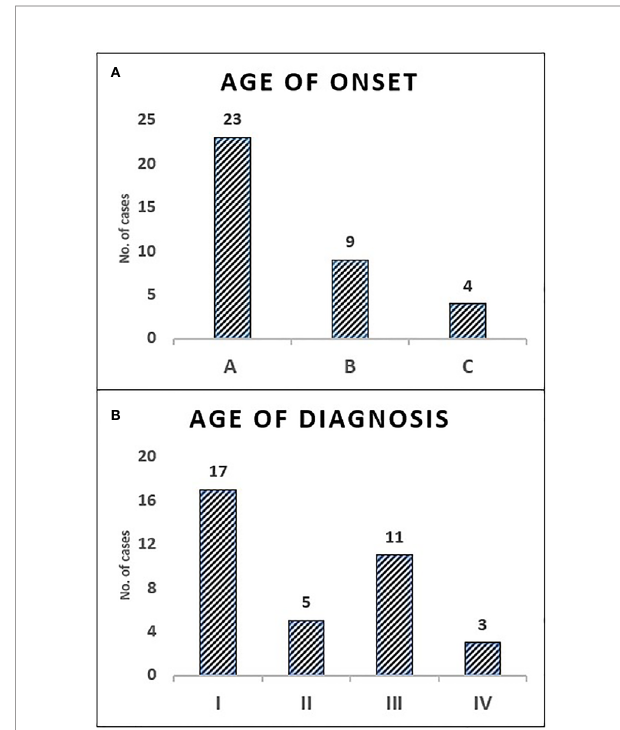
FIGURE 1 | The distribution of children with SCID in categories of age — onset and diagnosis. Onset age category A: (0 – 3 months) 63.9%, B: (4 – 6 months) 25%, C: (7 – 12 months) 11.1% (A) . Diagnosis age category I: (0 – 3 months) 47.2%, II: (4 – 6 months) 13.9%, III: (7 – 12 months) 30.6%, IV: (>12 months) 8.3% (B)